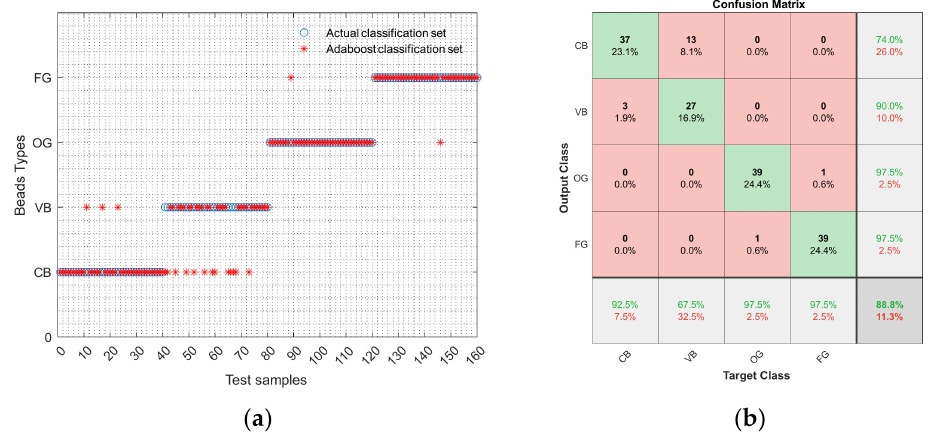
Figure 16. Identification results of AdaBoost. Figures shown in ( a , b ) are identification results of AdaBoost and its confusion